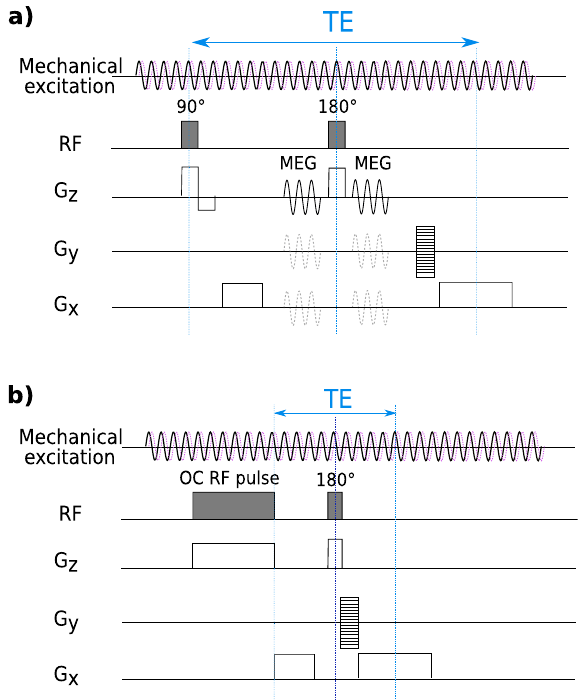
Figure 2. Sequence diagrams of ( a ) the classical MEG MRE and ( b ) the OC-based MRE used in this study.